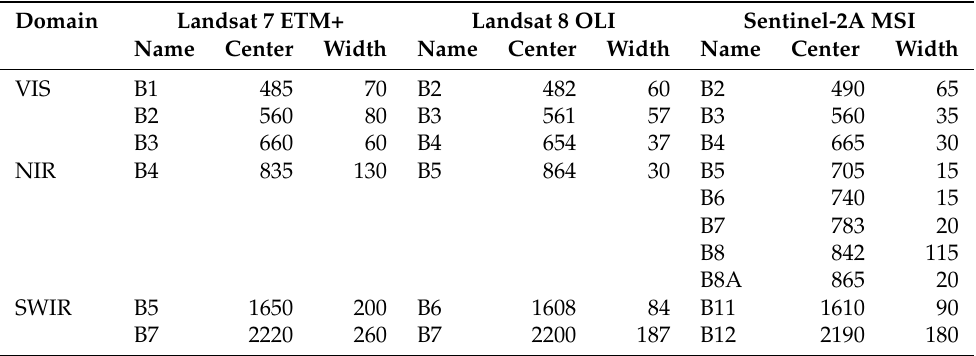
Table 1. Spectral band specifications for bands and missions used in this study (band centres and widths in nm), bands used for atmospheric correction were omitted [34,41]. Domain Landsat 7 ETM+ Landsat 8 OLI Sentinel-2A MSI Name Center Width